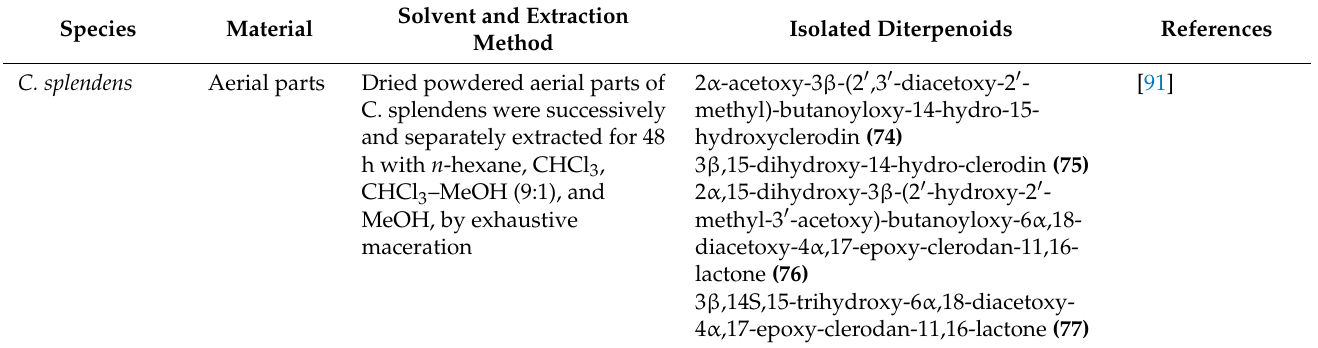
Table 10. The diterpenoid extraction method and C. splendens plant material for diterpenoid isolation. Solvent and Extraction Species Material Isolated Method